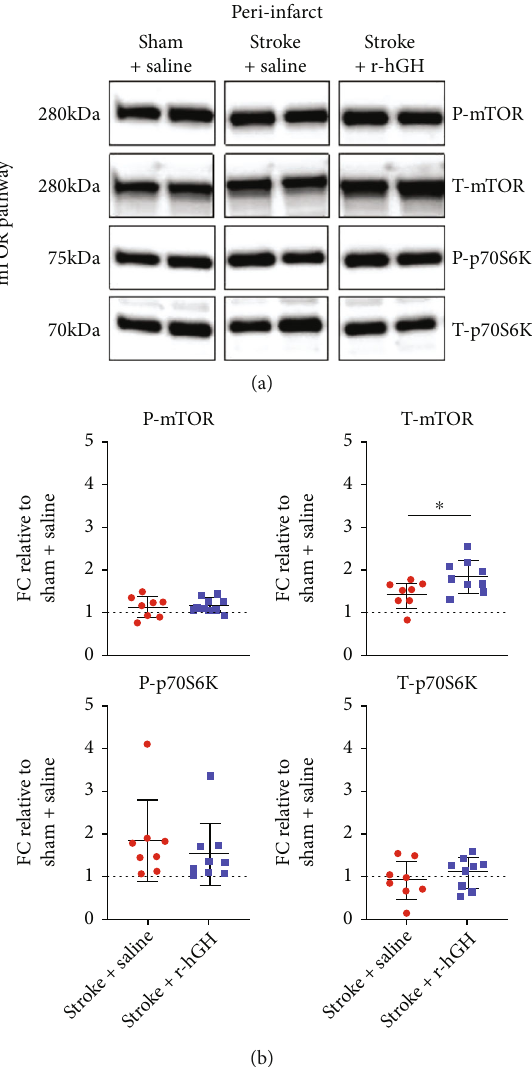
Figure 2: The e ff ect of recombinant human growth factor (r-hGH) treatment poststroke on mammalian target of rapamycin (mTOR) in the peri-infarct region. (a) Representative blots of phosphorylated-mTOR (P-mTOR, active form), total-mTOR (T-mTOR), phosphorylated- p70S6-kinase P-p70S6K), and total-p70S6k (T-p70S6K). (b) T-mTOR and T-p70S6K levels were normalized to β -actin. P-mTOR and P- p70S6K levels were normalized to T-mTOR and T-p70S6K, respectively. Levels were expressed as a fold change (FC) of mean ± SD for each group relative to the mean of the Sham+Saline group (dotted line). We found a signi fi cant increase in T-mTOR protein expression within the peri-infarct region in stroked mice treated with r-hGH (blue squares) compared with saline (red circles). ∗ p < 0 : 05 , 2-tailed t